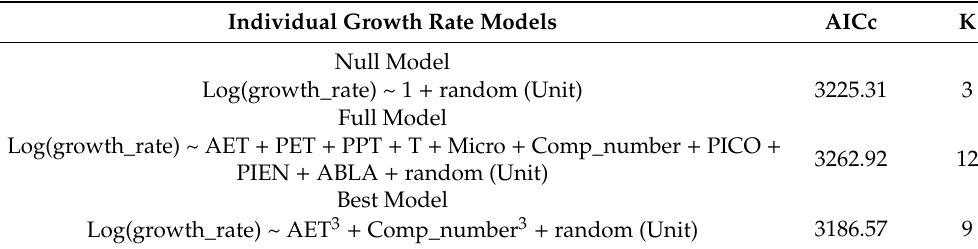
Table 6. Mixed e ff ects models of individual growth rate (AET = actual evapotranspiration during the growing season, PET = potential evapotranspiration during the growing season, PPT = mean annual precipitation, T = mean annual temperature, Micro = microsite presence / absence, Comp = number of competitors within 3.59m radius, PICO = Pinus contorta presence or absence within plot, PIEN = Picea Engalmanii presence or absence within plot, ABLA = Abies lasiocarpa presence or absence within plot).